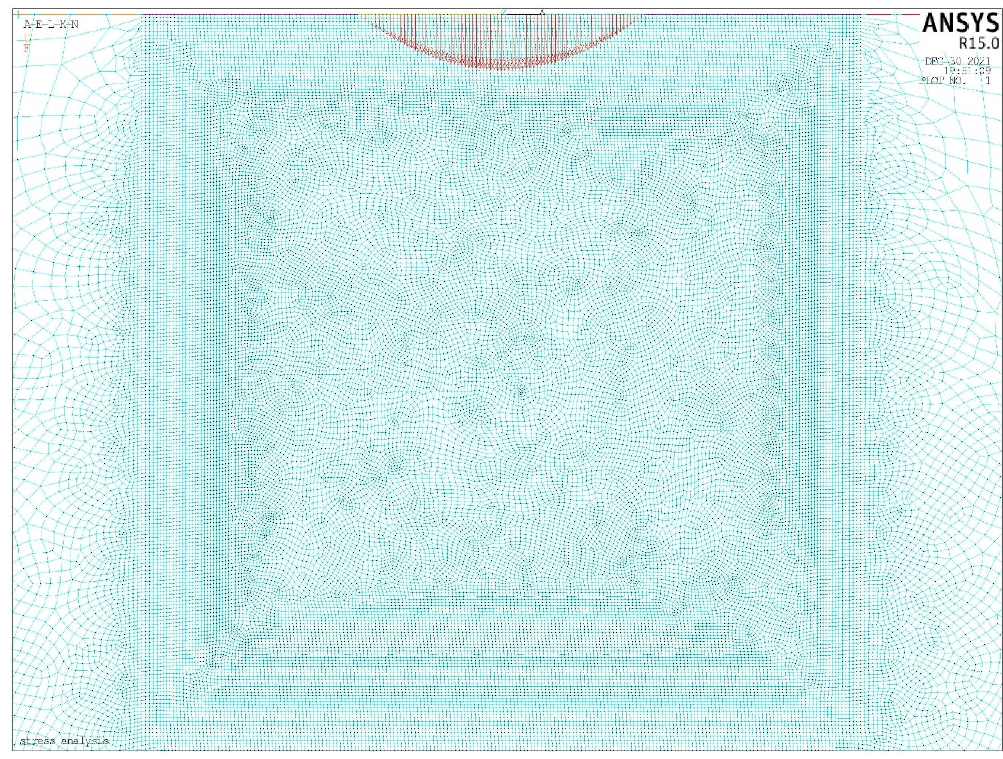
Figure 7. Distribution of elements near the load.